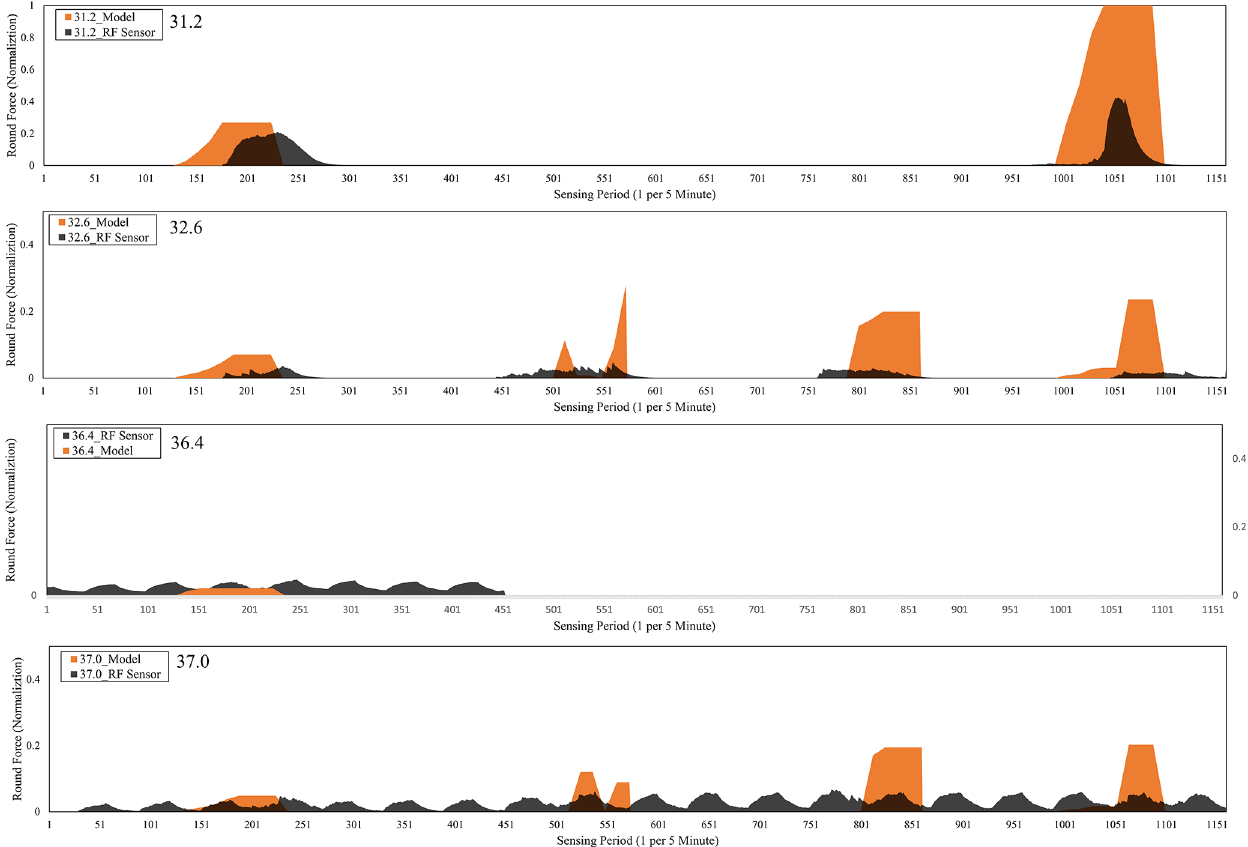
Figure 11. Comparison graph of the data value of round force sensor and black ice prediction value of system dynamics